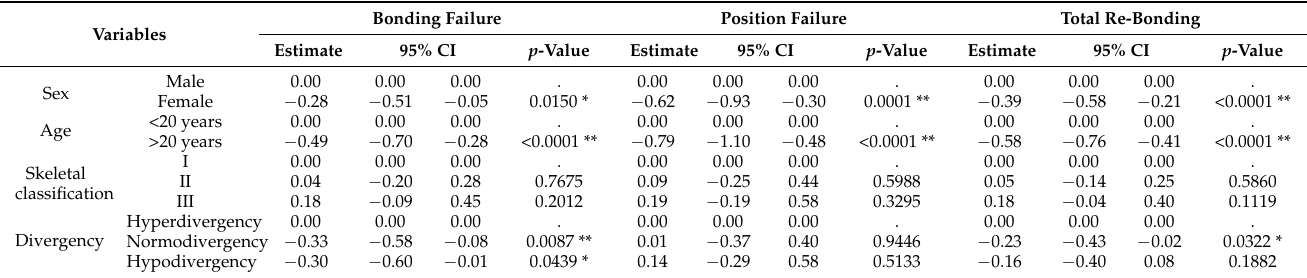
Table 3. Multiple linear regression analysis with dependent variables of sex, age, skeletal classification, and skeletal divergency.